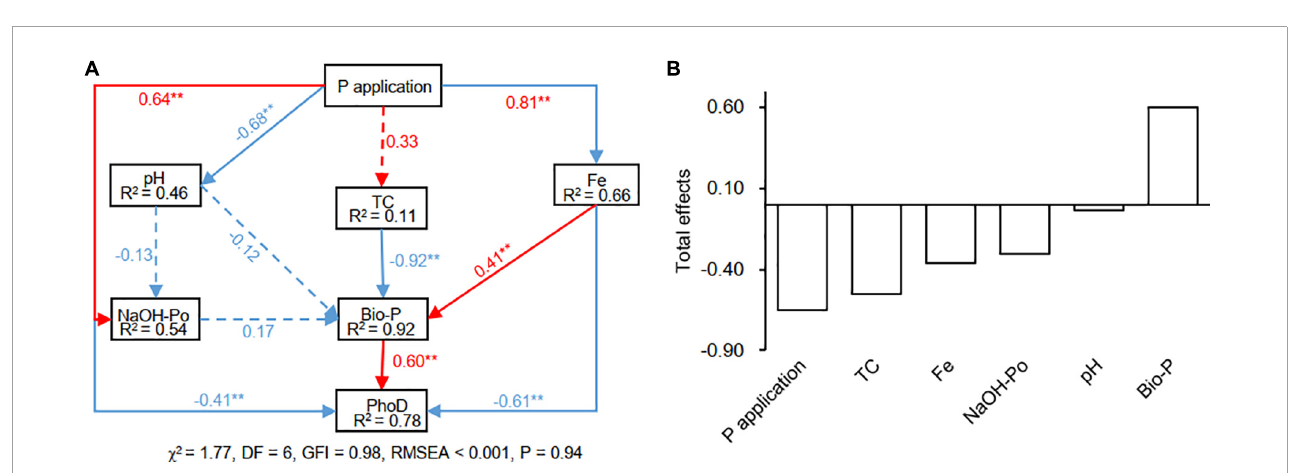
FIGURE7 The effects of soil properties on phoD-harboring microbial community structure as estimated using the structural equation model. To simplify the SEM model, the PCA first axis score of each sample was used to represent the phoD-harboring microbial community structure. Panel (A) , the numbers in blocks are the variance explained by the model ( R 2 ), and the numbers on arrows are standardized direct path coefficients. Red and blue arrows indicate positive and negative effects, respectively. The total effects of environmental factors on phoD-harboring microbial community structure are presented in Panel (B) . TC, total carbon; Bio-P, bioavailable P. ∗∗ P <